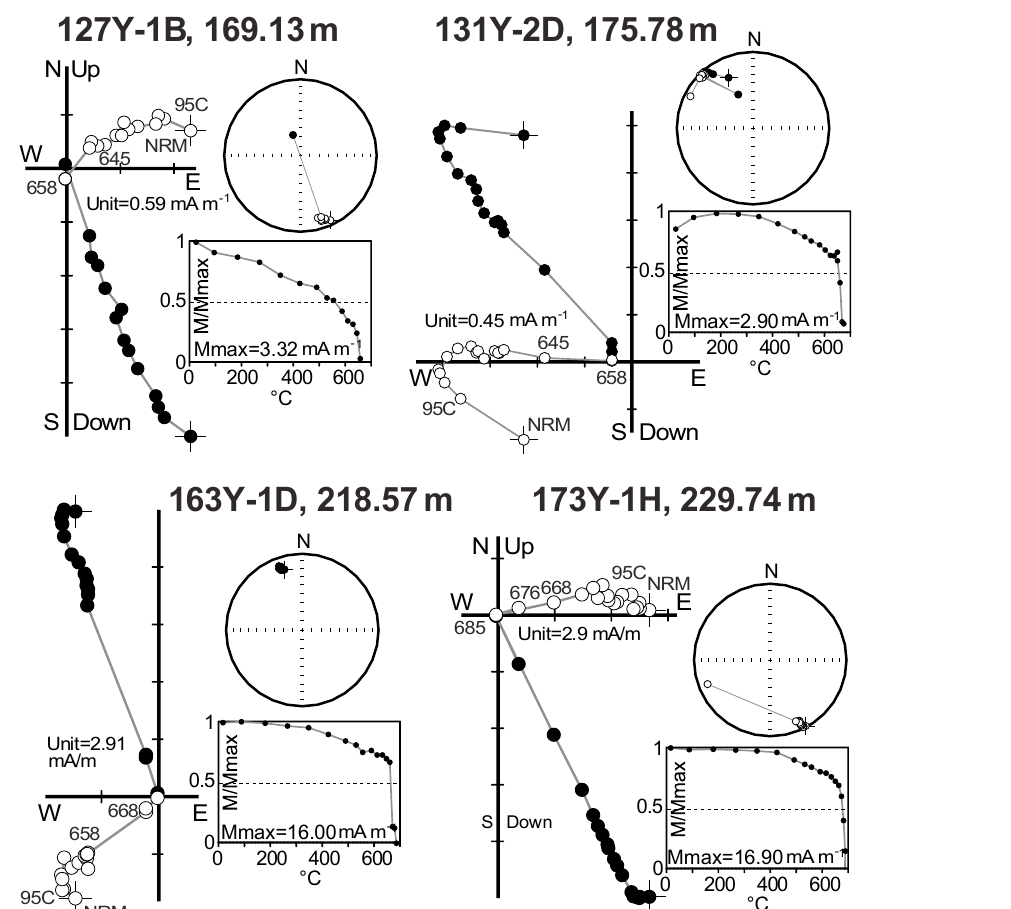
Figure 14. Examples of orthogonal progressive demagnetization diagrams for the Moenkopi Formation showing the end point of the magne- tization vector plotted onto the horizontal (filled symbols) and vertical (open symbols) planes (NS-EW, EW-Up/Dn) for individual specimens from core segments of Moenkopi Formation rocks intersected in CPCP Phase 1 Core 2B that have been subjected to progressive thermal de- magnetization. Demagnetization steps, in temperatures ( ◦ C) are given alongside selected vertical projection data points. NRM is the natural remanent magnetization. Also shown are normalized intensity decay plots showing response to progressive thermal treatment (abscissa is temperature, ◦ C) and equal area stereographic projections of the magnetization vector measured at each step. Note that the coordinate axes for each and every diagram are identical in orientation and the diagrams are in geographic coordinates, assuming that each core segment is properly